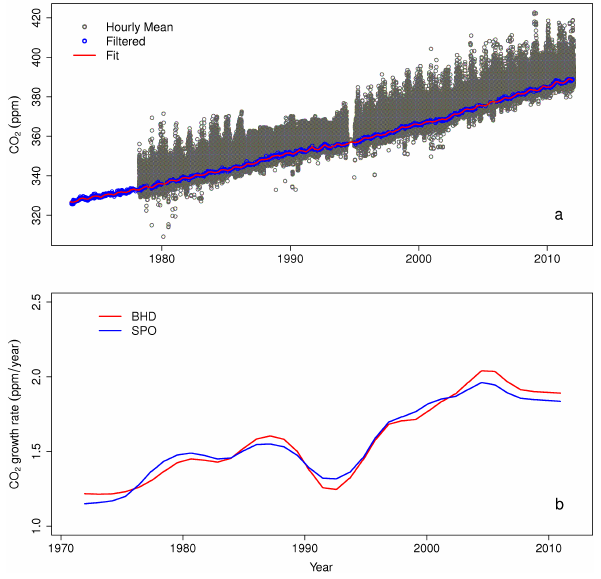
Fig. 3. (a) Baring Head CO 2 time series, observations during the fil- tered “Steady periods” (Sect. 5.2) are plotted (blue) with a fit to the observations (red) calculated using STL. Hourly averages are de- picted from 1978 (grey), historically the primary focus was to iden- tify steady periods and during 1987 to 1994 the analyser span was reduced to improve sensitivity resulting in a truncation of hourly the data. (b) Shows the long-term trend of the Baring Head (BHD) and South Pole (SPO) time series calculated on monthly mean data using STL with a 121 month trend filter and a 5yr seasonal